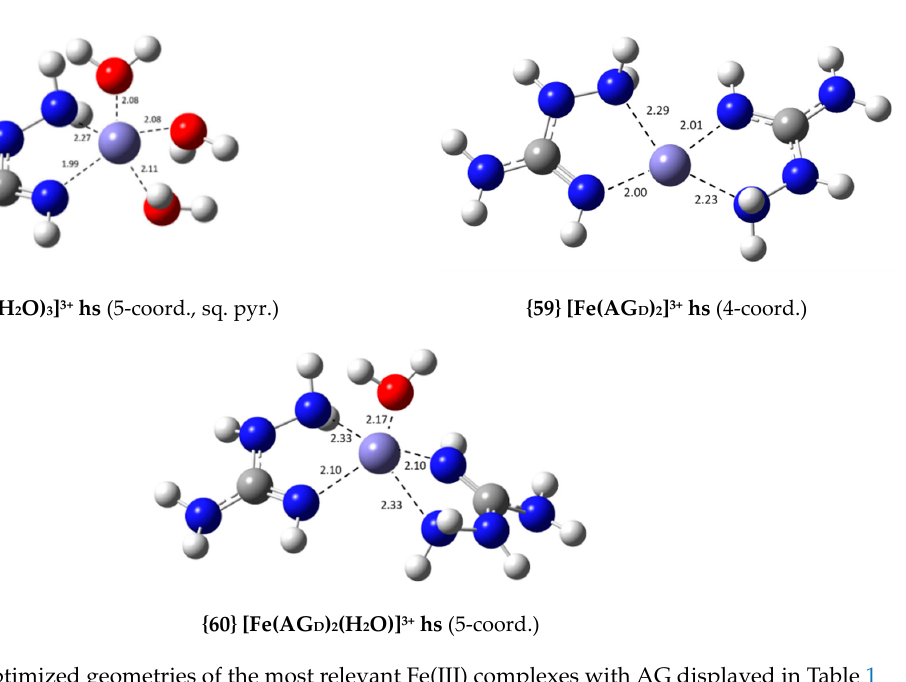
Figure 2. Optimized geometries of the most relevant Fe(III) complexes with AG displayed in Table 1 (bond distances in Å); high- (hs) and low-spin (ls) complexes are identified. The only 1:3 complexes with AG as bidentate ligands that are exergonic are those with AG D , complexes {14} and {16}, with ∆ G f° values of − 36.8 and − 37.9 kcal/mol, respectively. These are the most thermodynamically stable Fe(III) complexes with AG. Unlike the three other conformations of